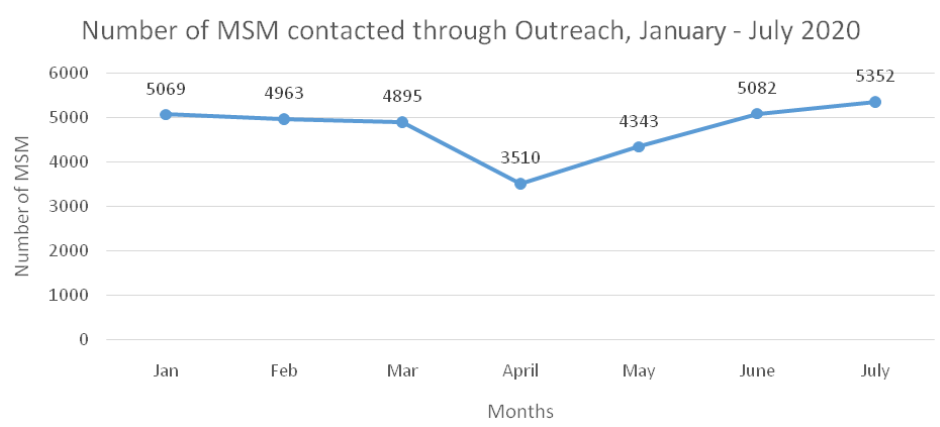
Figure 1. MSM contacted through peer outreach in the three sites (combined program data, Jan–July